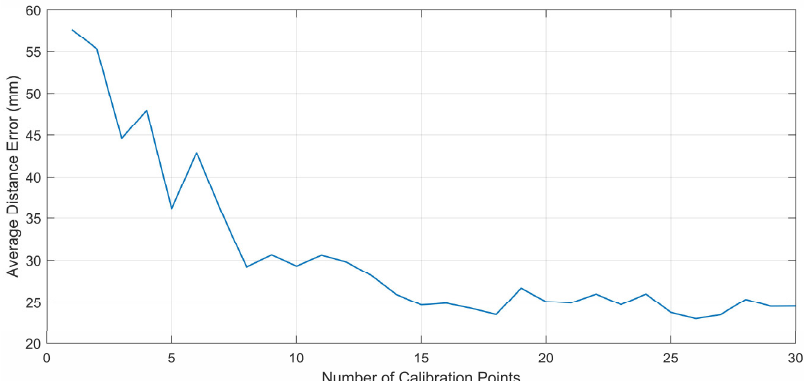
Figure 9. The average distance error of calibration results in different numbers of calibration points.